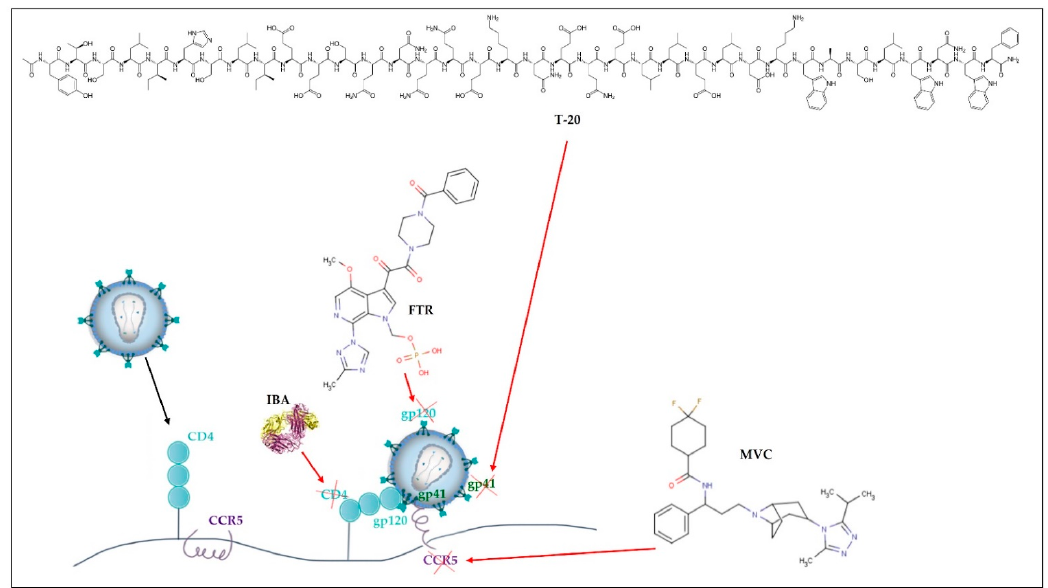
Figure 3. Cell entry inhibitors and fusion inhibitors. Ibalizumab-uiyk (IBA) blocks CD4 and maraviroc (MVC), blocks CCR5 receptors from host cells. Enfuvirtide (T-20) blocks gp41 and fostemsavir tromethamine (FTR) blocks gp120 from the virus.